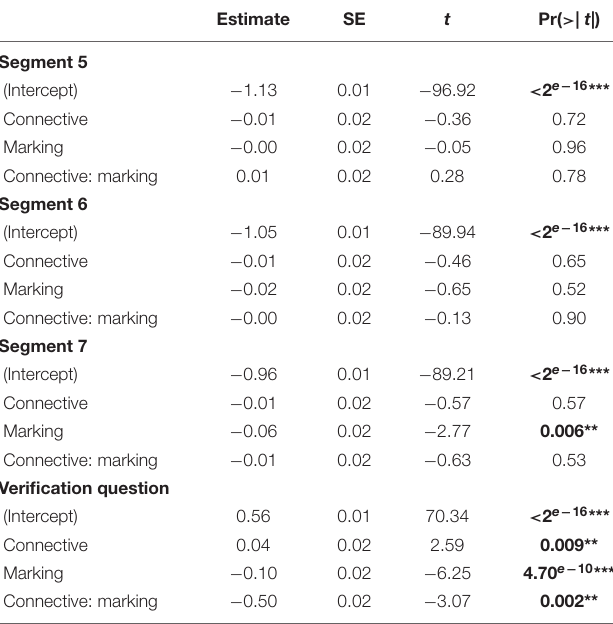
TABLE 5 | Experiment 2, outputs for the models of Segments 5–7 and for the response times to the verification question.